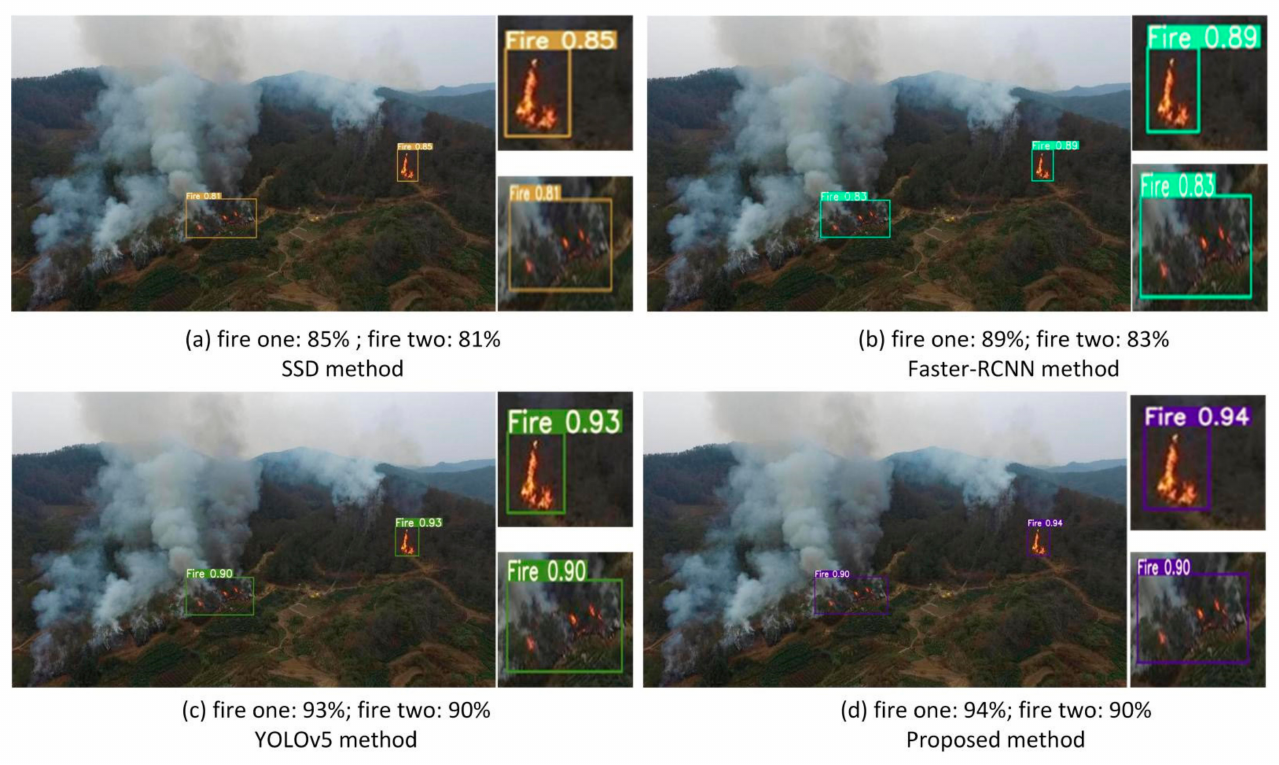
Figure 9. Outdoor fire